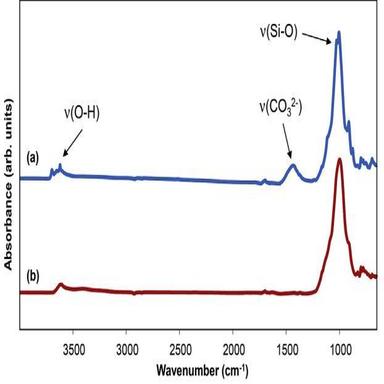
Mid-infrared spectra of two different shale samples with (a) high calcite/kaolinite (Varians Formation in the Swiss Molasse Basin) and (b) low calcite/kaolinite content (Goldwyer Formation in the Canning Basin).